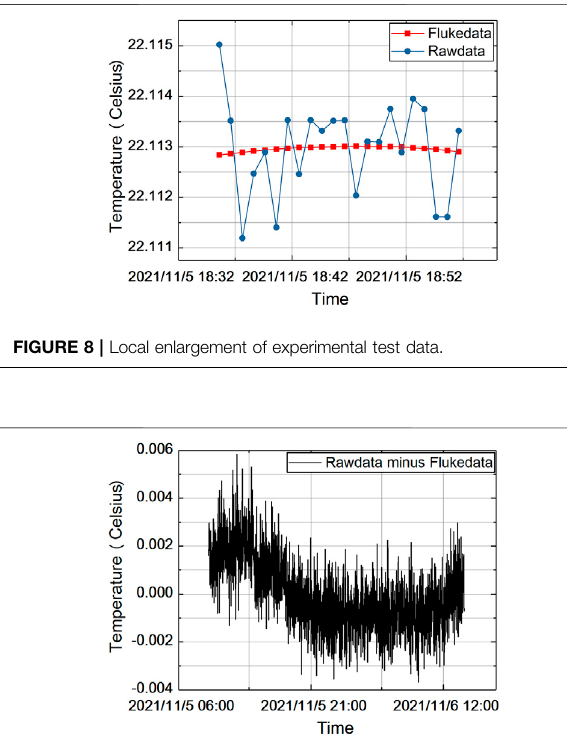
FIGURE 9 | Deviation of raw measurement